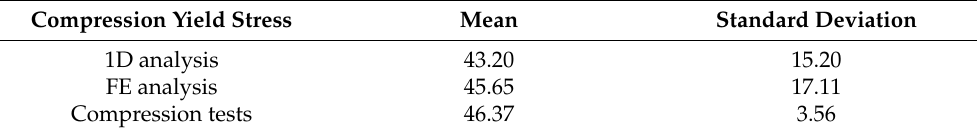
Table 6. Average values of the compression yield stress (MPa), and standard